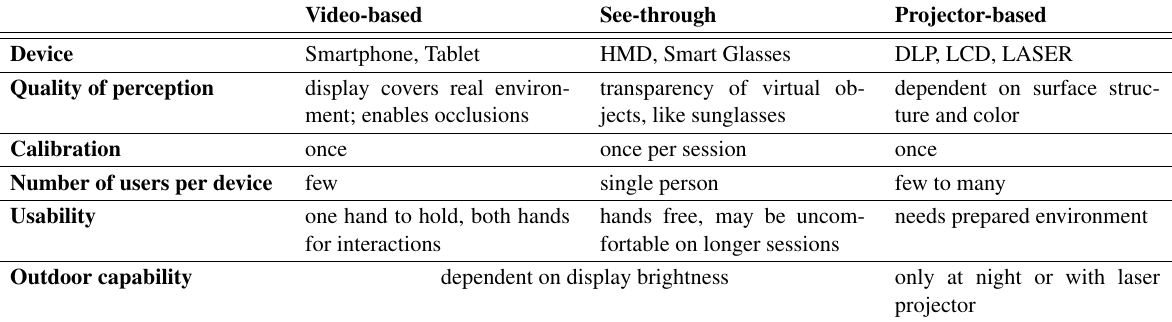
Table 1. Some characteristics for the three different types of augmentation: video-based, see-through and projector-based.